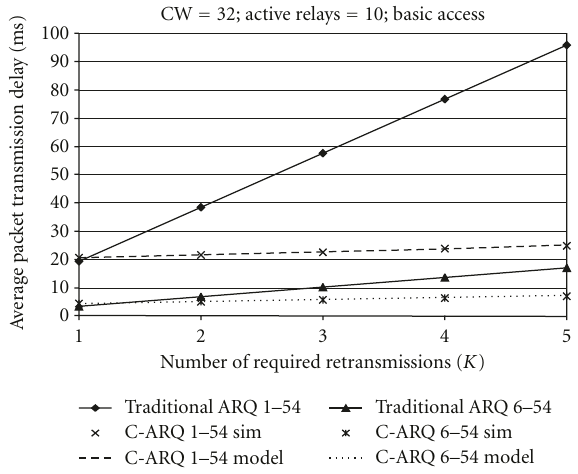
Figure 4: Average Packet Transmission Delay (relay low rate regime).